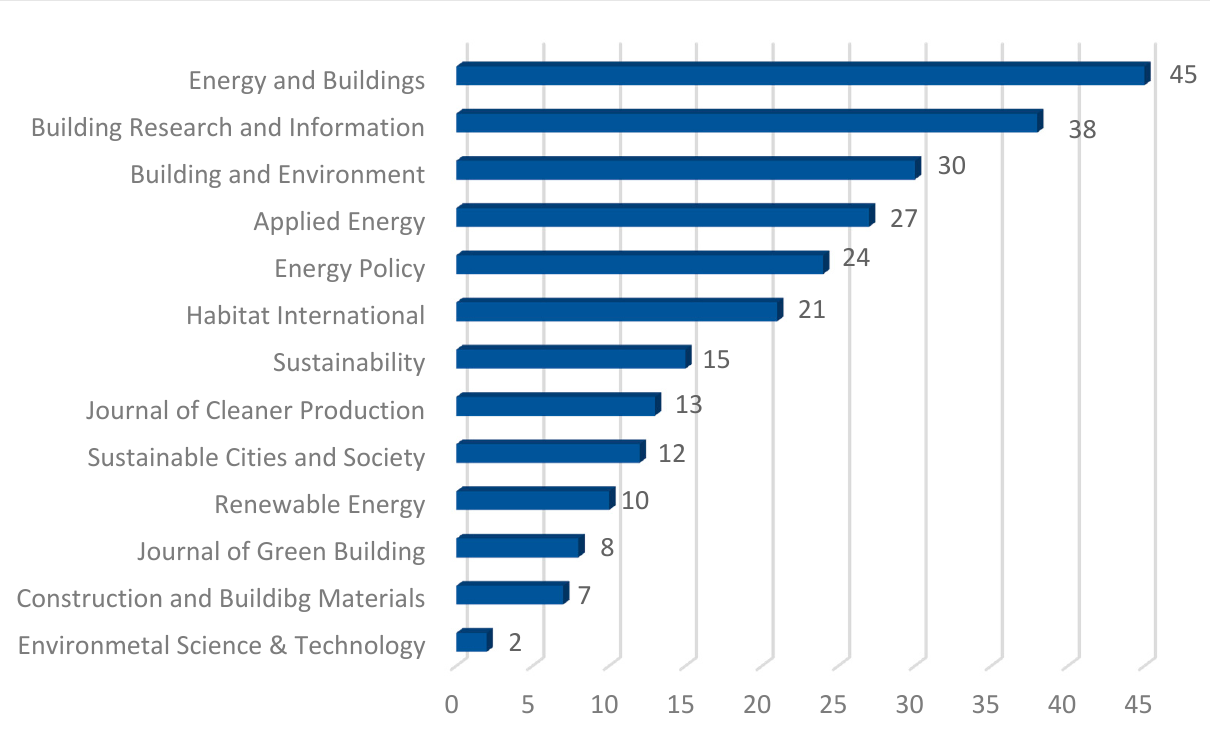
Figure 3. Journal publication contributions.